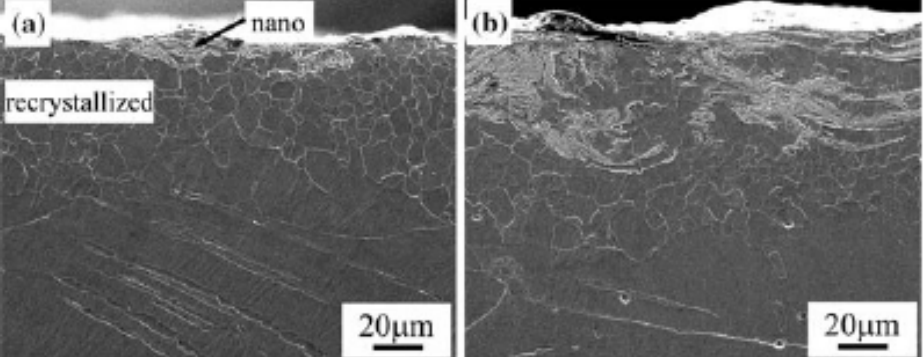
Figure 10. Microstructure of shot peened Fe-3.29Si after